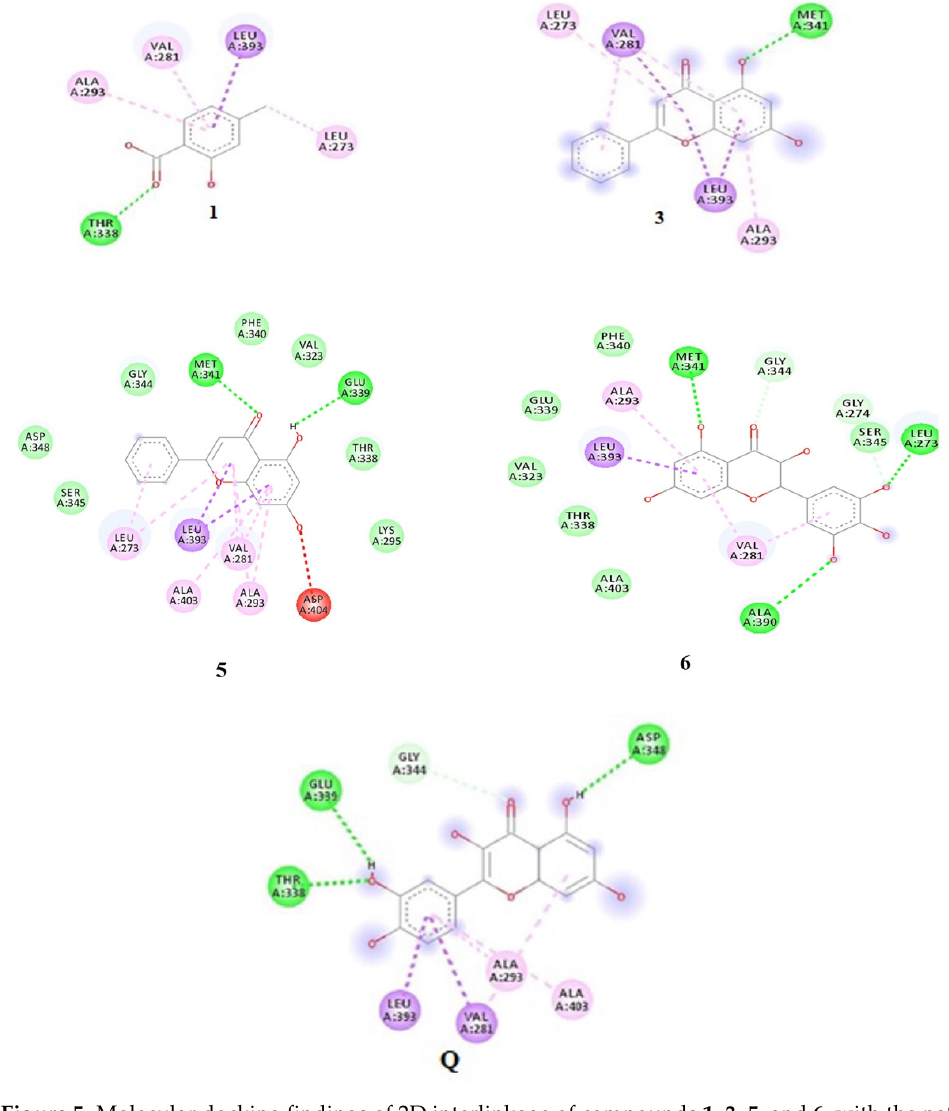
Figure 5. Molecular docking findings of 2D interlinkage of compounds 1 , 3 , 5 , and 6 , with the native ligand showing as Q. Green dashes exhibit conventional H-bonds.